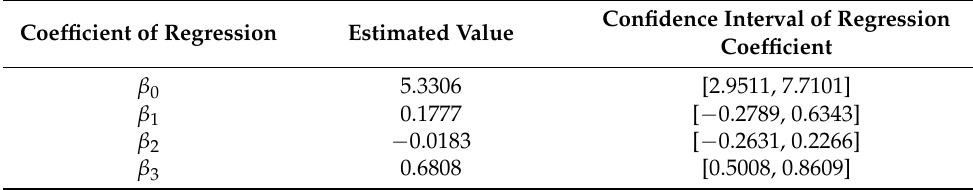
Table 6. Regression results of drilling force prediction model.